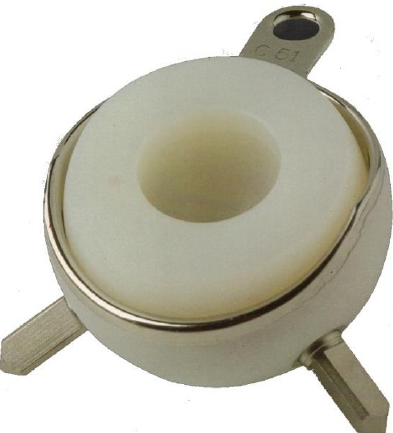
Figure 2. Original Bousquet design «tripode configuration». Courtesy of SER F, Décines, France.